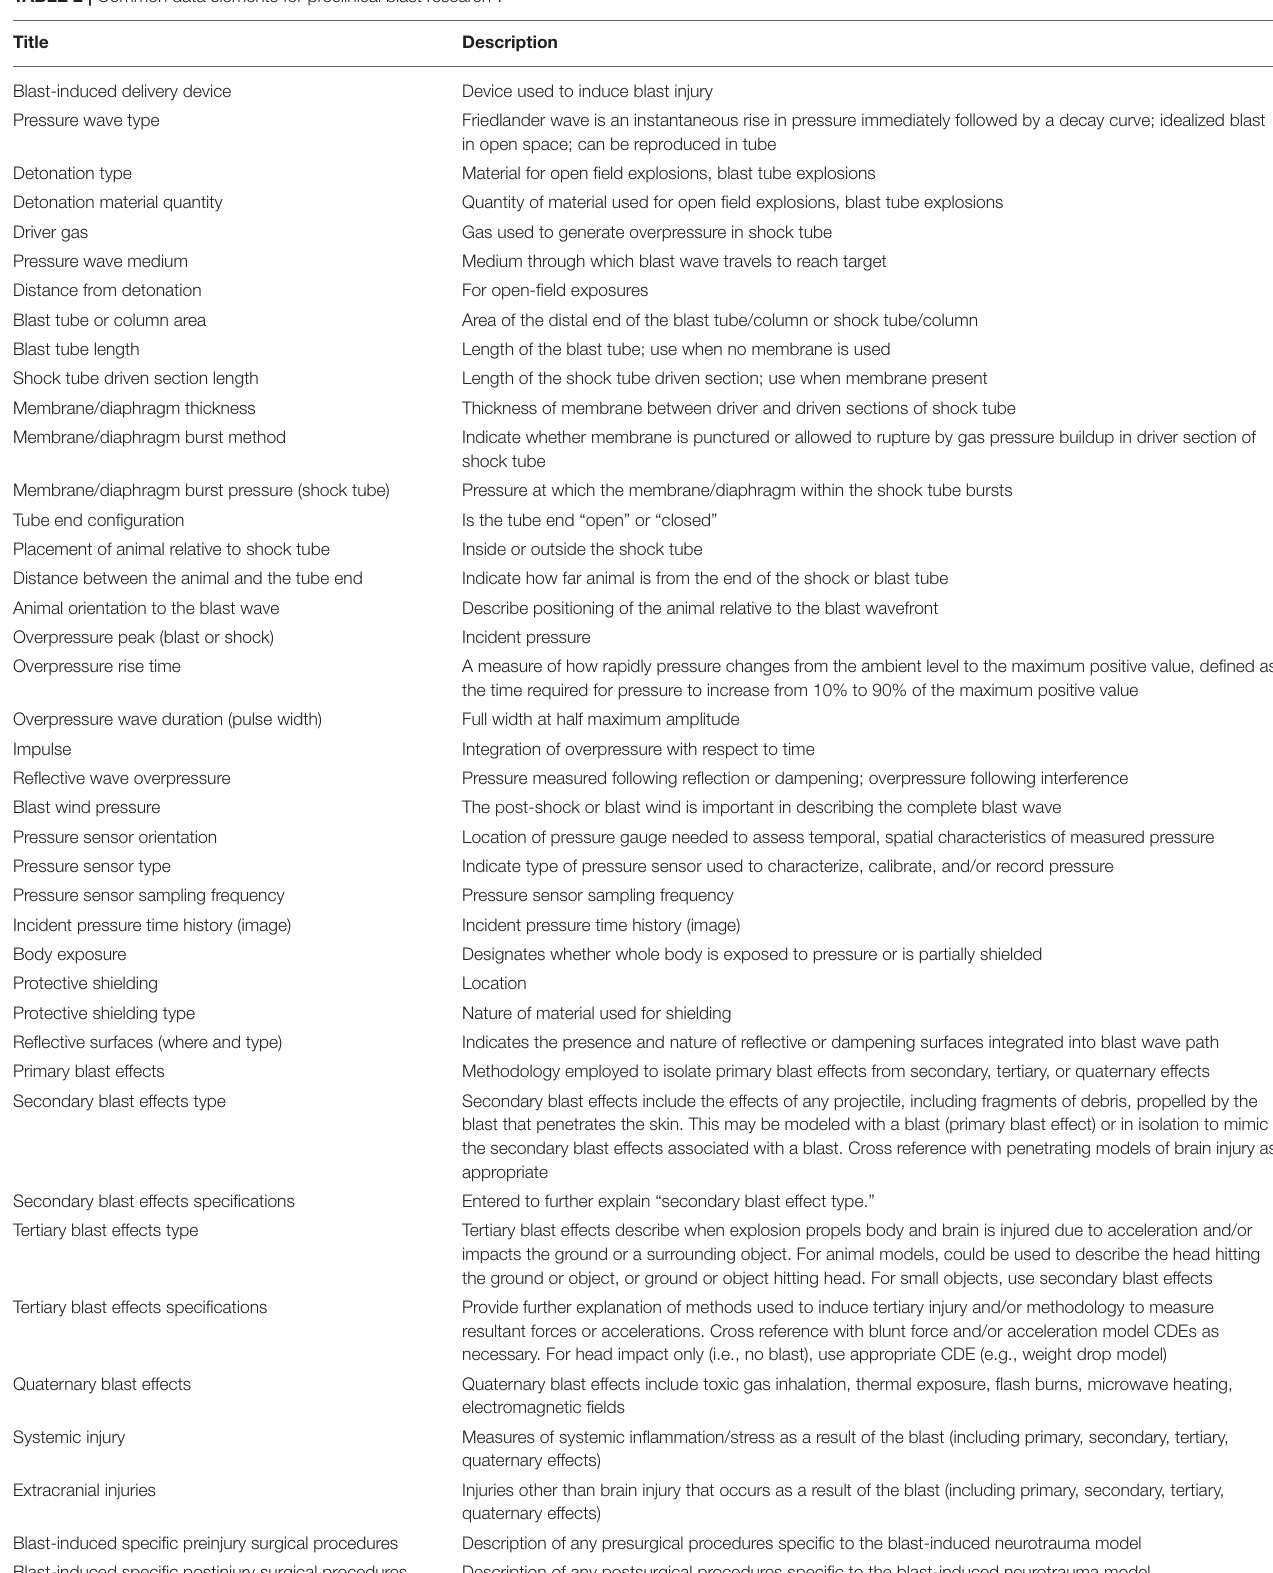
TABLE 2 | Common data elements for preclinical blast